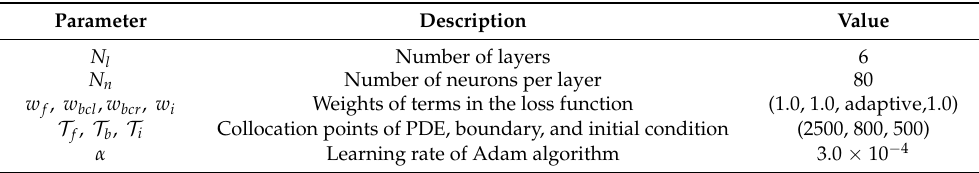
Table 1. Parameters to define the neural network for the adsorption experiment.